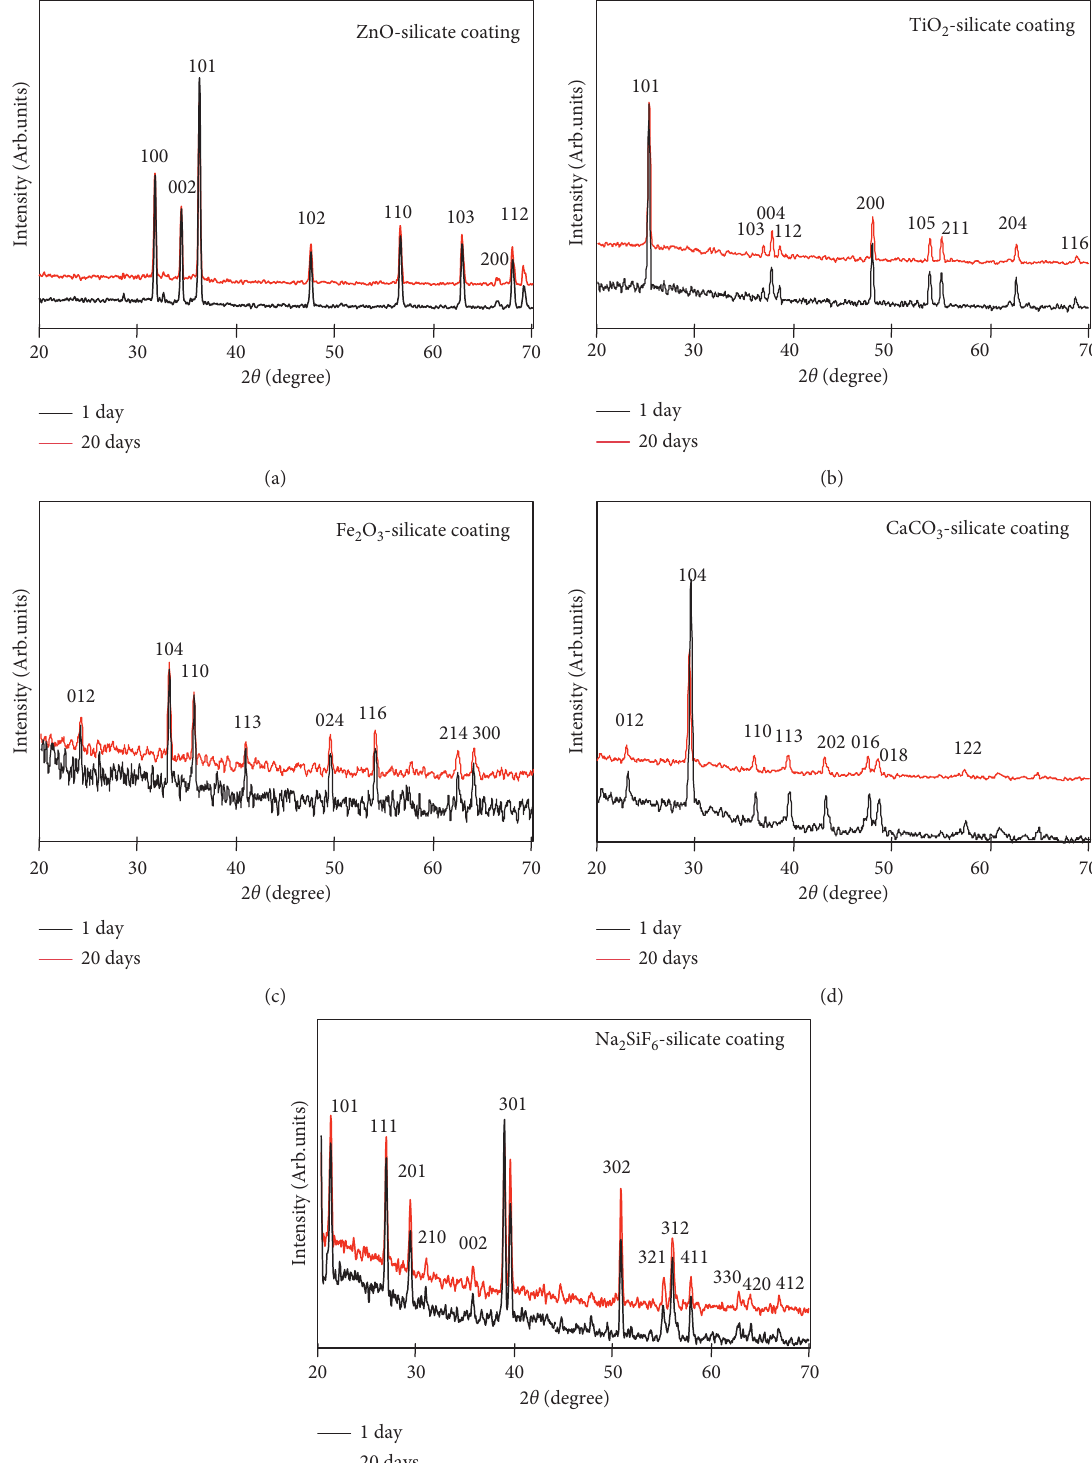
Figure 2: Powder X-ray diffraction pattern of the of ZnO-silicate (a), TiO silicate coating (e) at 1 day and 20 days of